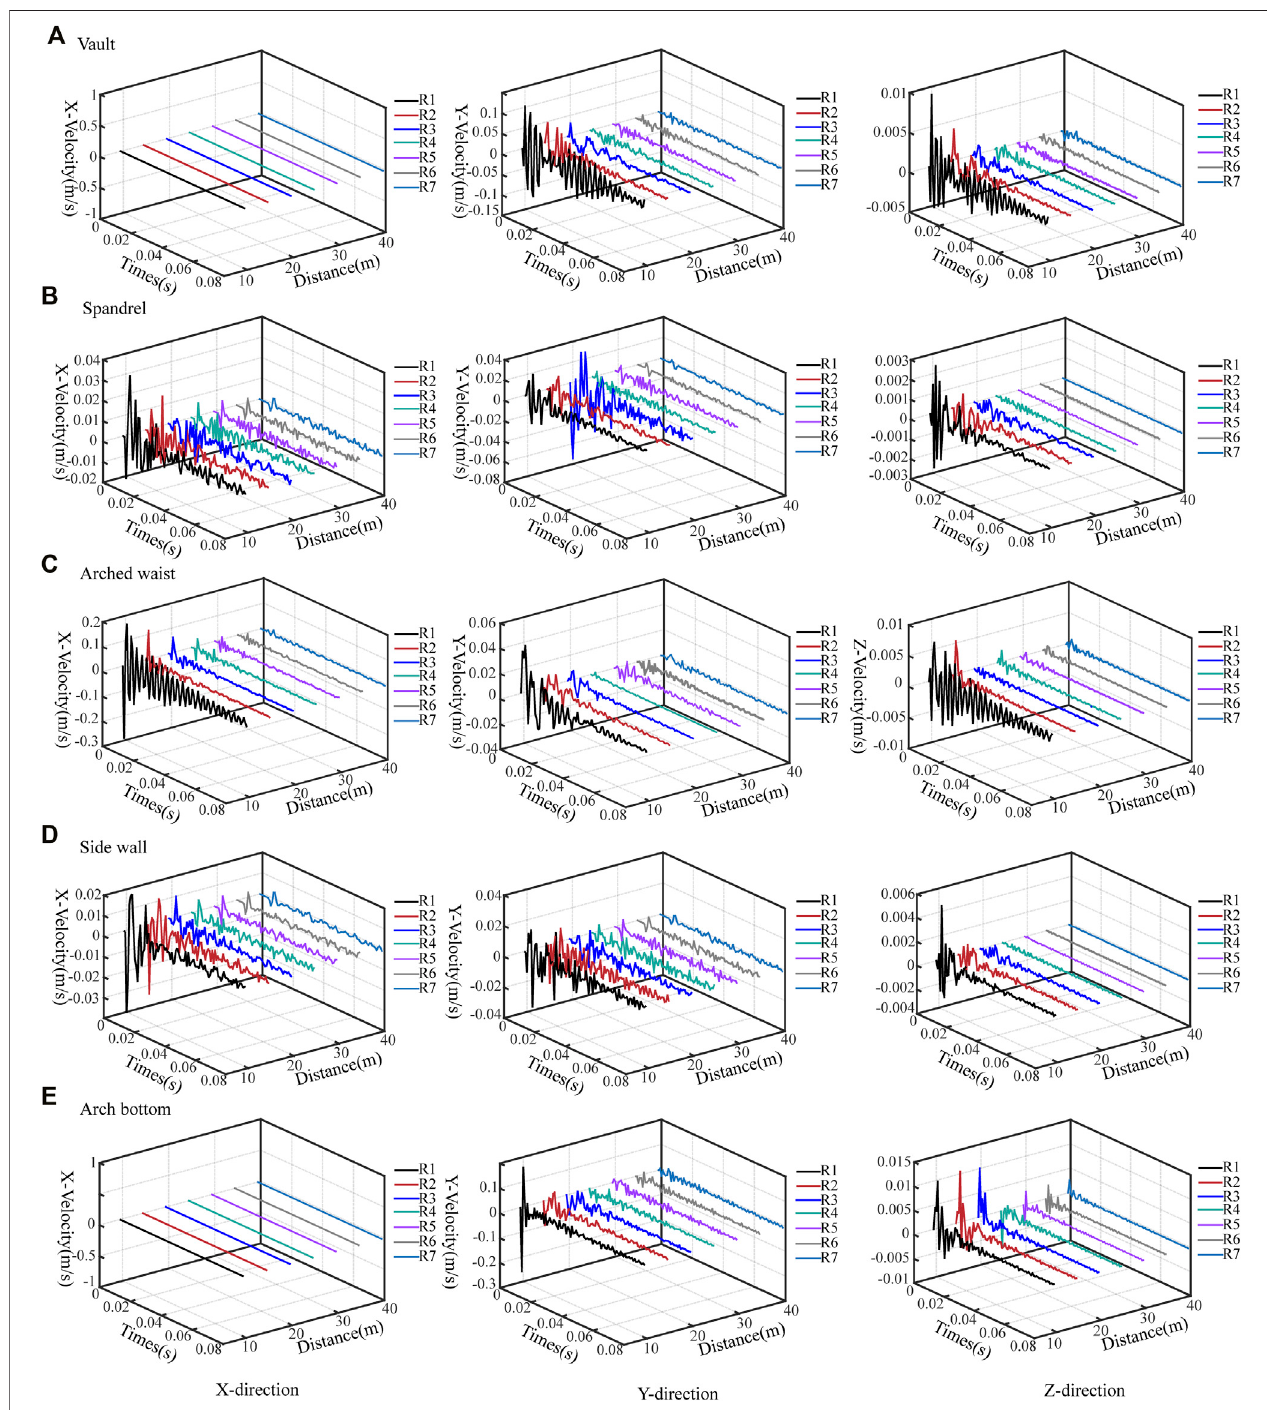
FIGURE 7 | Vibration velocity distribution in the X, Y, and Z directions. (A) Vault; (B) Spandrel; (C) Arched waist; (D) Side wall; (E) Arch bottom.